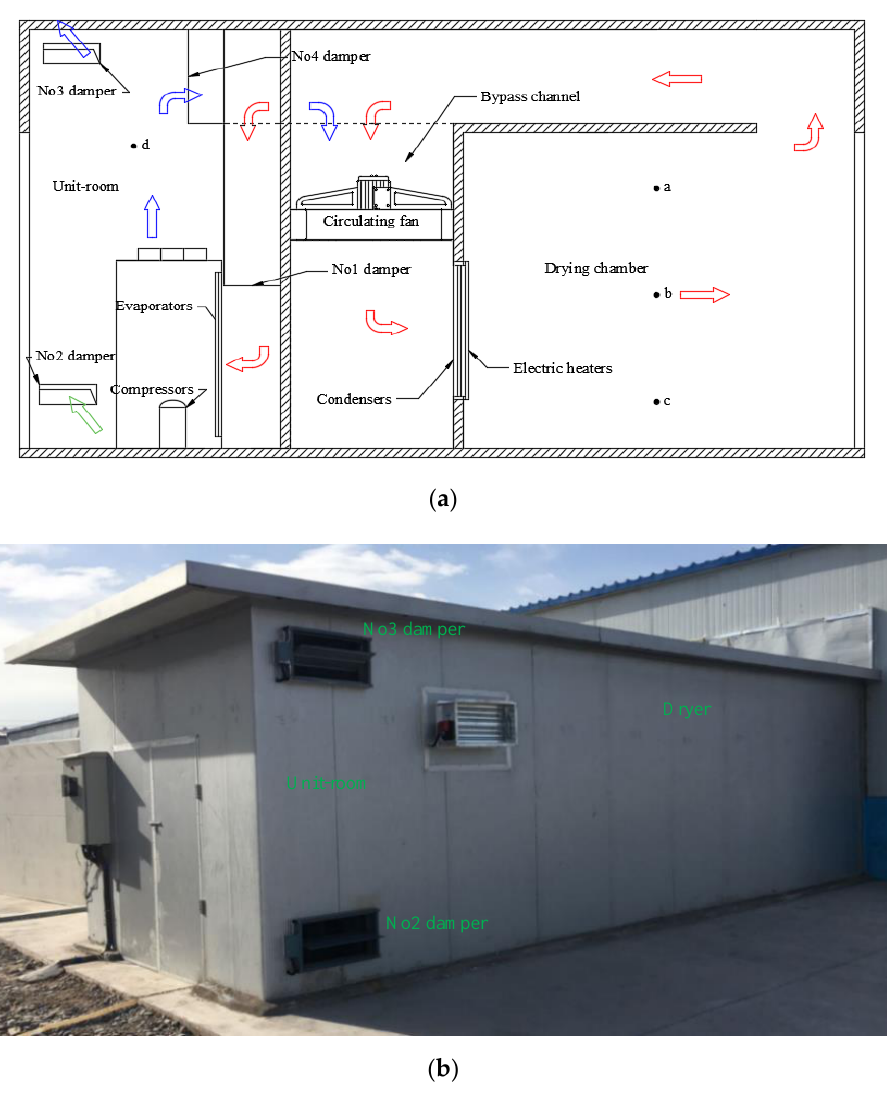
Figure 6. The novel partially open-loop heat pump dryer with the unit-room: ( a ) Schematic diagram; ( b ) practical prototype.